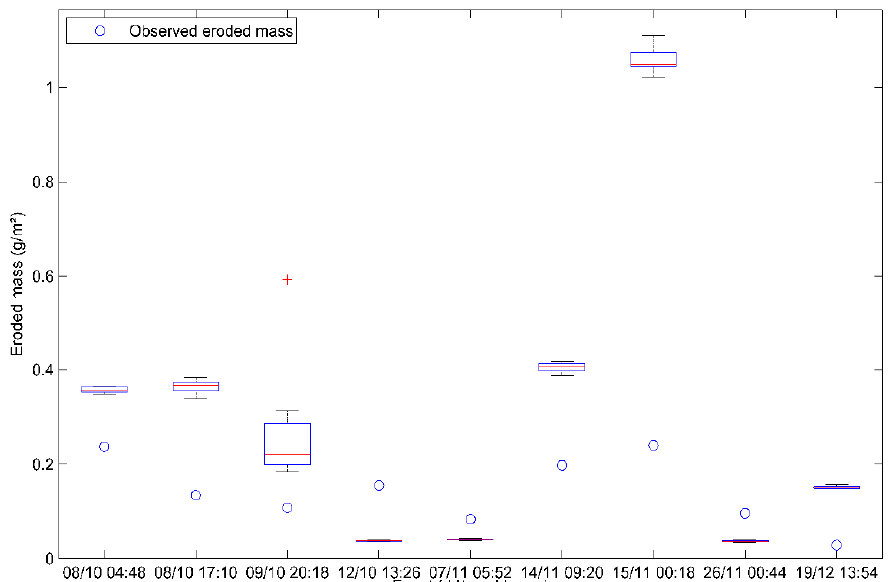
Figure 5. Boxplots of simulated wash-off load obtained with the three modeling approaches. The central red mark is the median, the edges are the 25th and the 75th percentiles and the whiskers extend to the extreme values that are not considered as outliers. The measured wash-off load is presented as blue circles.